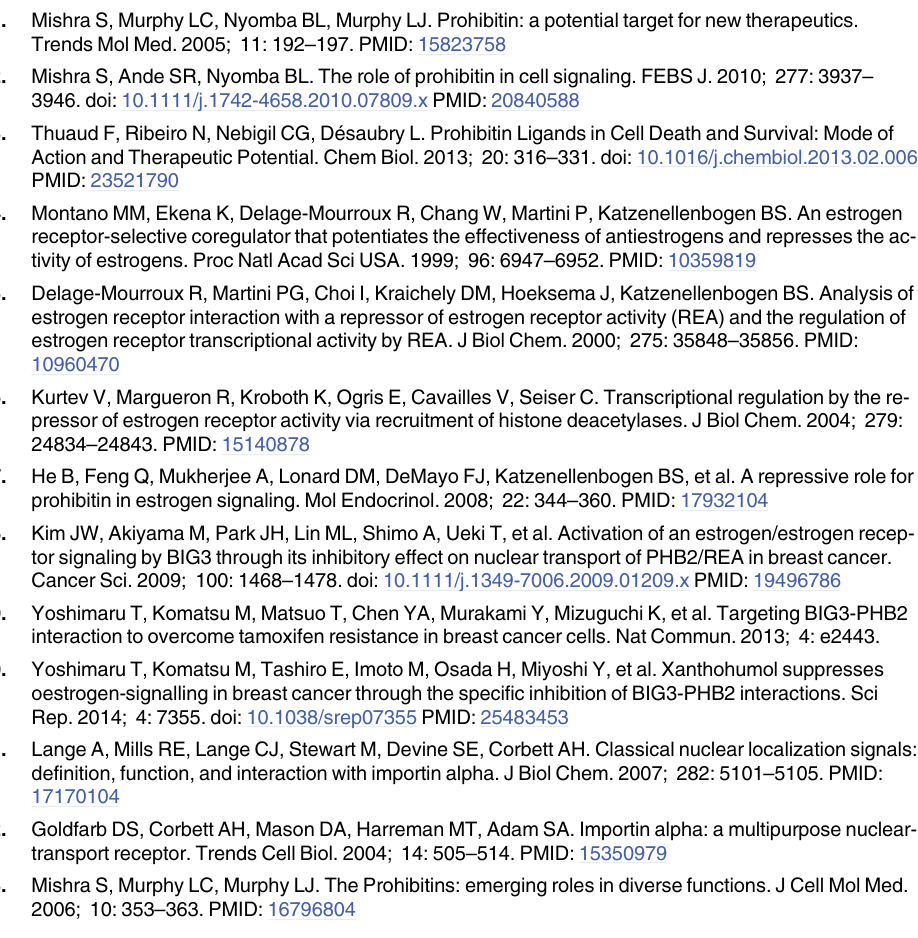
S6 Fig. A, Full-length of images of all immunoblots of Fig 5A. B, Fig Full-length of images of all immunoblots of Fig 5B. C, Full-length of images of all immunoblots of Fig 5D. D, Full- length of images of all immunoblots of Fig 5E. (PDF) S7 Fig. Representative immunofluorescence images of the subcellular localization of BIG3. BIG3 (green), DAPI (blue).